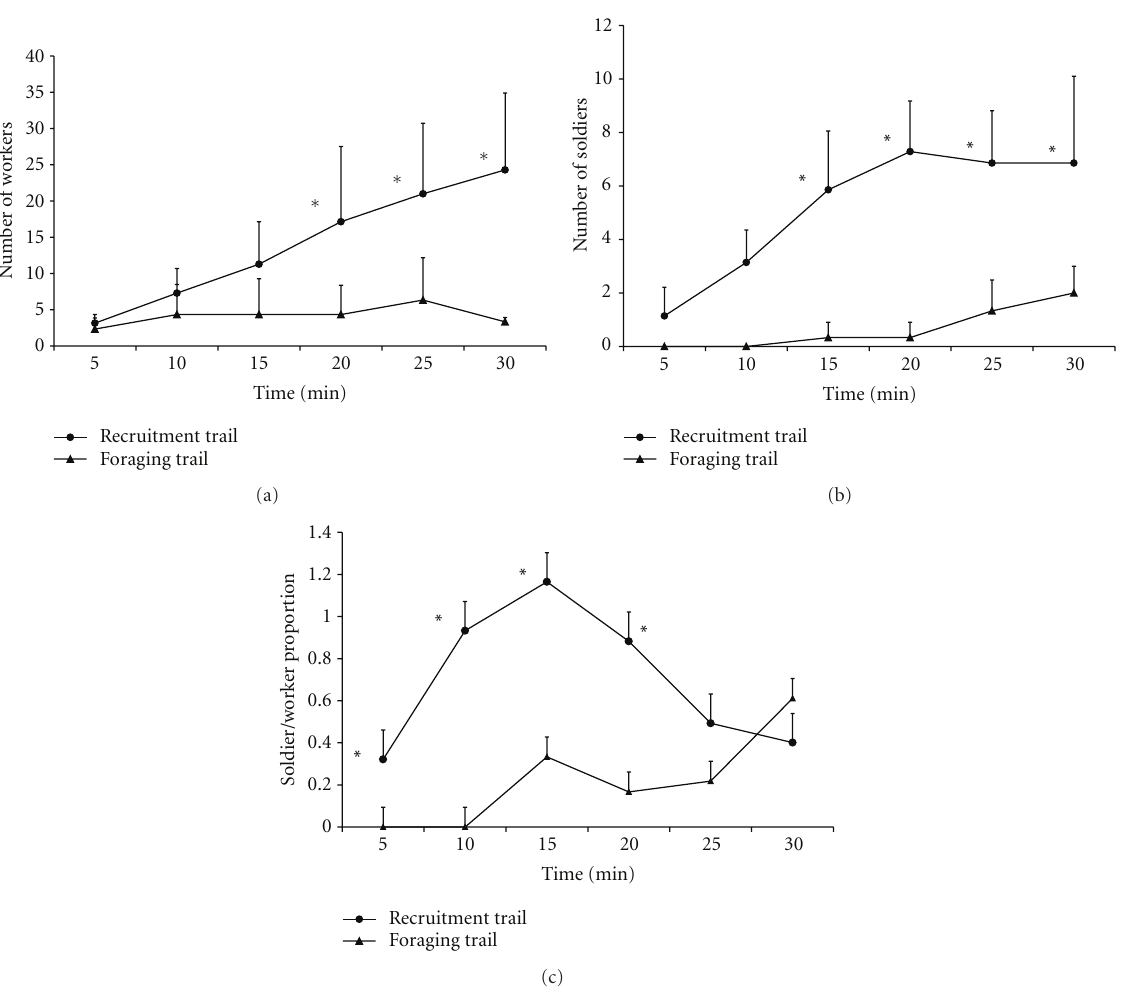
Figure 3: Mean number ( ± SD) of workers (a), soldiers (b), and proportion of soldiers and workers (c) of Coptotermes gestroi following a foraging or recruitment trail within 30 min. N = 20. Asterisks indicate significant di ff erences between types of trails ( P < 0 . 05; Mann- Whitney test)